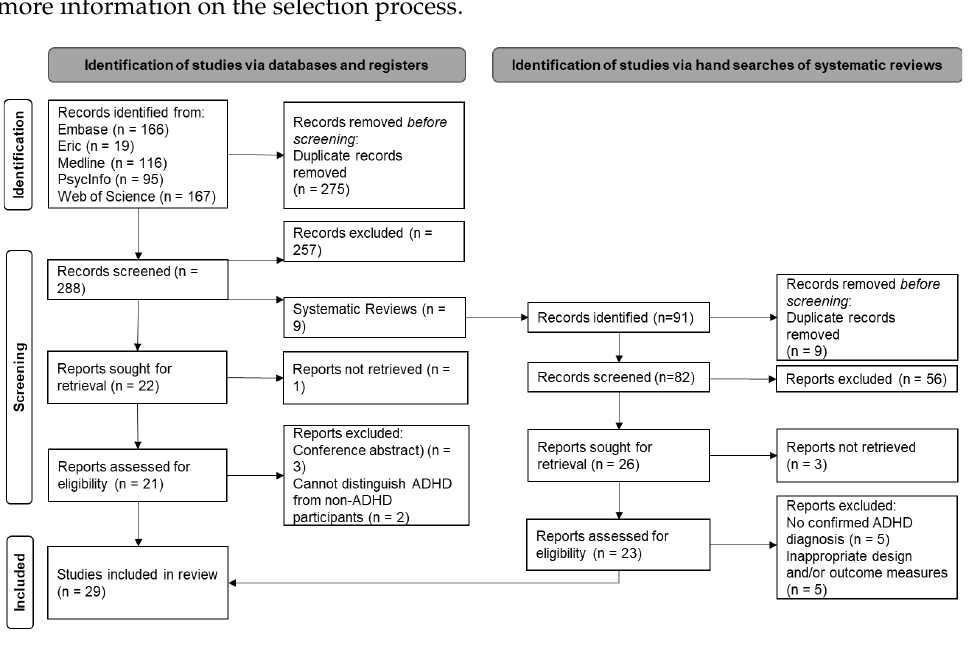
Figure 1. Prisma 2020 Flow Diagram for the